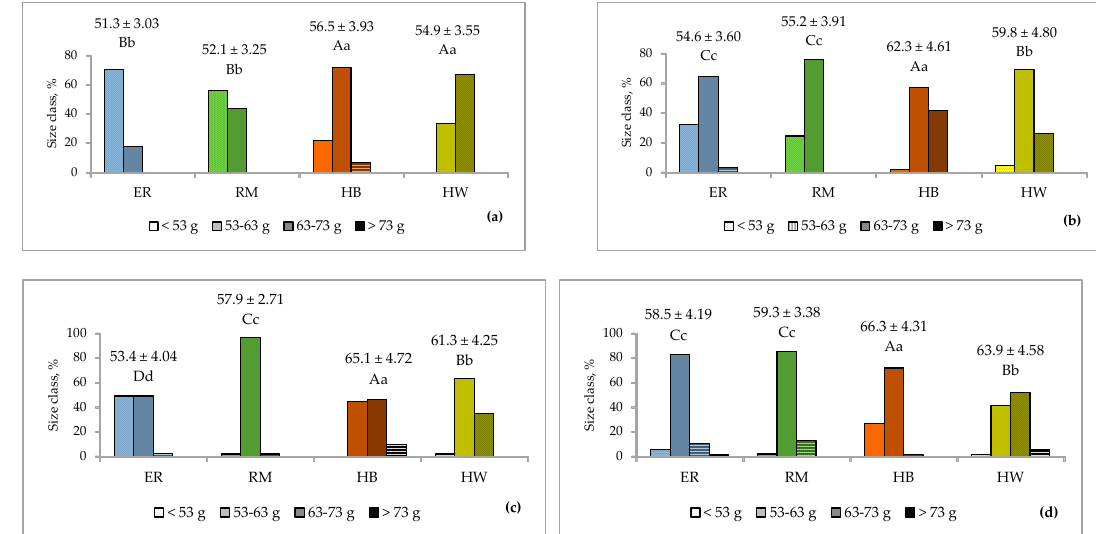
Figure 1 . Effect of genotype 1 on the egg weight (lsmeans ± SD, g) and size class at 31 (a), 35 (b), 39 (c) 8 Figure 1. E ff ect of genotype 1 on the egg weight (lsmeans ± SD, g) and size class at 31 ( a ), 35 ( b ), 39 ( c ) and 43 ( d ) weeks of age of the hens. Di ff erent letters among genotypes indicate di ff erent values and 43 (d) weeks of age of the hens. 9 for the egg weight (lsmeans). a, b, c, d: p < 0.05; A, B, C, D: p < 0.01. 1 Genotype: ER—Ermellinata